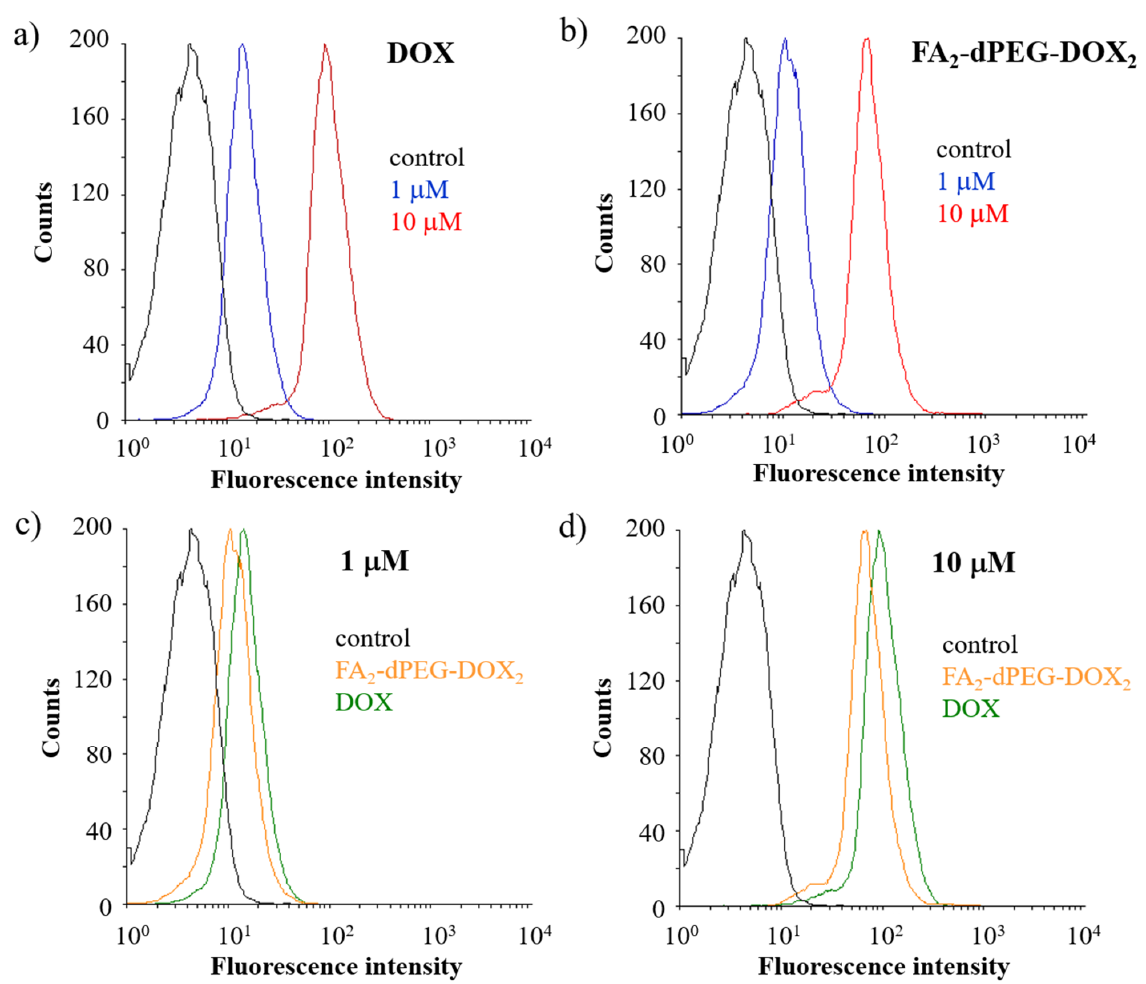
Figure 5. Flow cytometric measurement of doxorubicin uptake into triple-negative human breast cancer cell line (MDA-MB-231) cells. Concentration-dependent uptake of free doxorubicin ( a ) and the conjugated doxorubicin ( b ) (black line: untreated control; blue line: 1 µM; red line: 10 µM). Comparison of DOX and FA 2 -PEG-DOX 2 internalization with representative figures regarding the uptake of free doxorubicin and the conjugated drug at a concentration of 1 µM ( c ) and 10 µM ( d ) (black line: untreated control; orange line: FA 2 -dPEG-DOX 2 ; green line: free doxorubicin).